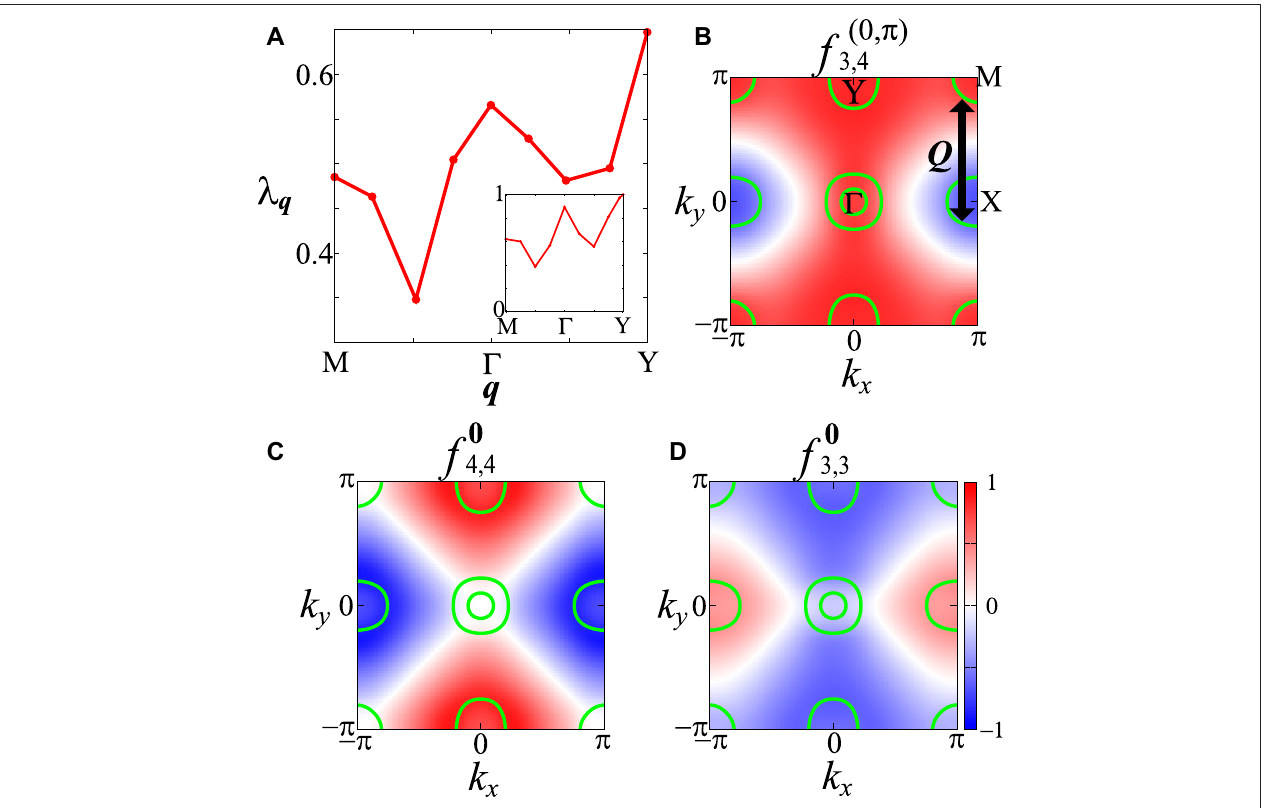
FIGURE 10 | (A) q dependence of λ q with self-energy for r = 0.68 at T = 5 meV in BaFe 2 As 2 , and that without self-energy for r = 0.30 at T = 32.4 meV in the inset. ( k ) with self-energy, which is given by the off-diagonal orbitals 3 and 4. k dependences of form factors at (B) k dependence of the dominant form factor at q = (0, π ), f q 3 , 4 q = 0 , (C) f 0 4 , 4 ( k ) , and (D) f 0 3 , 3 ( k ) with self-energy. Green lines denote